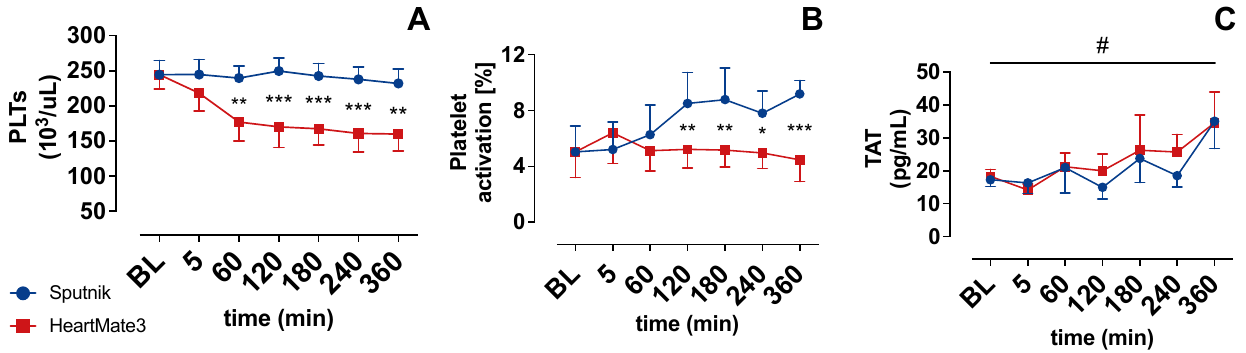
Figure 5. ( A ) Platelets (PLTs), ( B ) platelet activation, and ( C ) thrombin/antithrombin complex (TAT) over time. Baseline (BL). * p < 0.05; ** p < 0.01; *** p < 0.001; # p < 0.05. Platelet count decreased in the HeartMate 3 test circuit from 244 ± 49 × 10 3 / µ L to 177 ± 67 × 10 3 / µ L after 60 min of circulation. In the further course, the PLT count in the HeartMate 3 group remained lower in comparison to the Sputnik group. For the Sputnik group, PLT remained almost constant all the